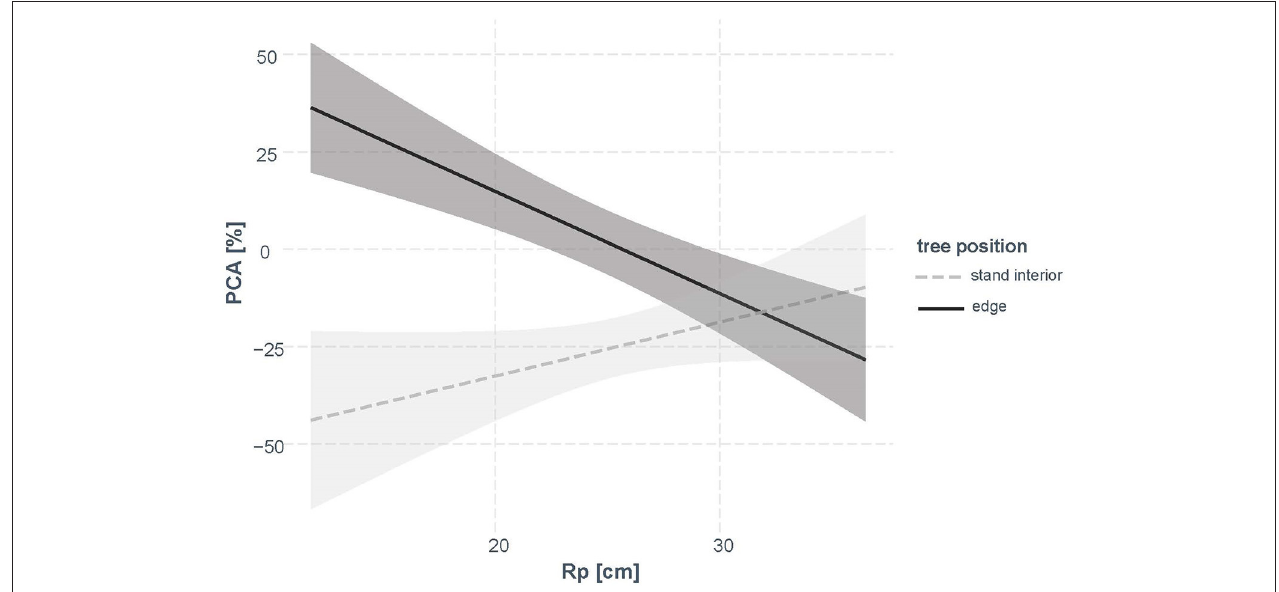
FIGURE 6 | Interaction plot of “tree position” and Rp (stem radius prior to cutting) according to the statistical model ( Table 4 ). CI (95%) are shown in gray.